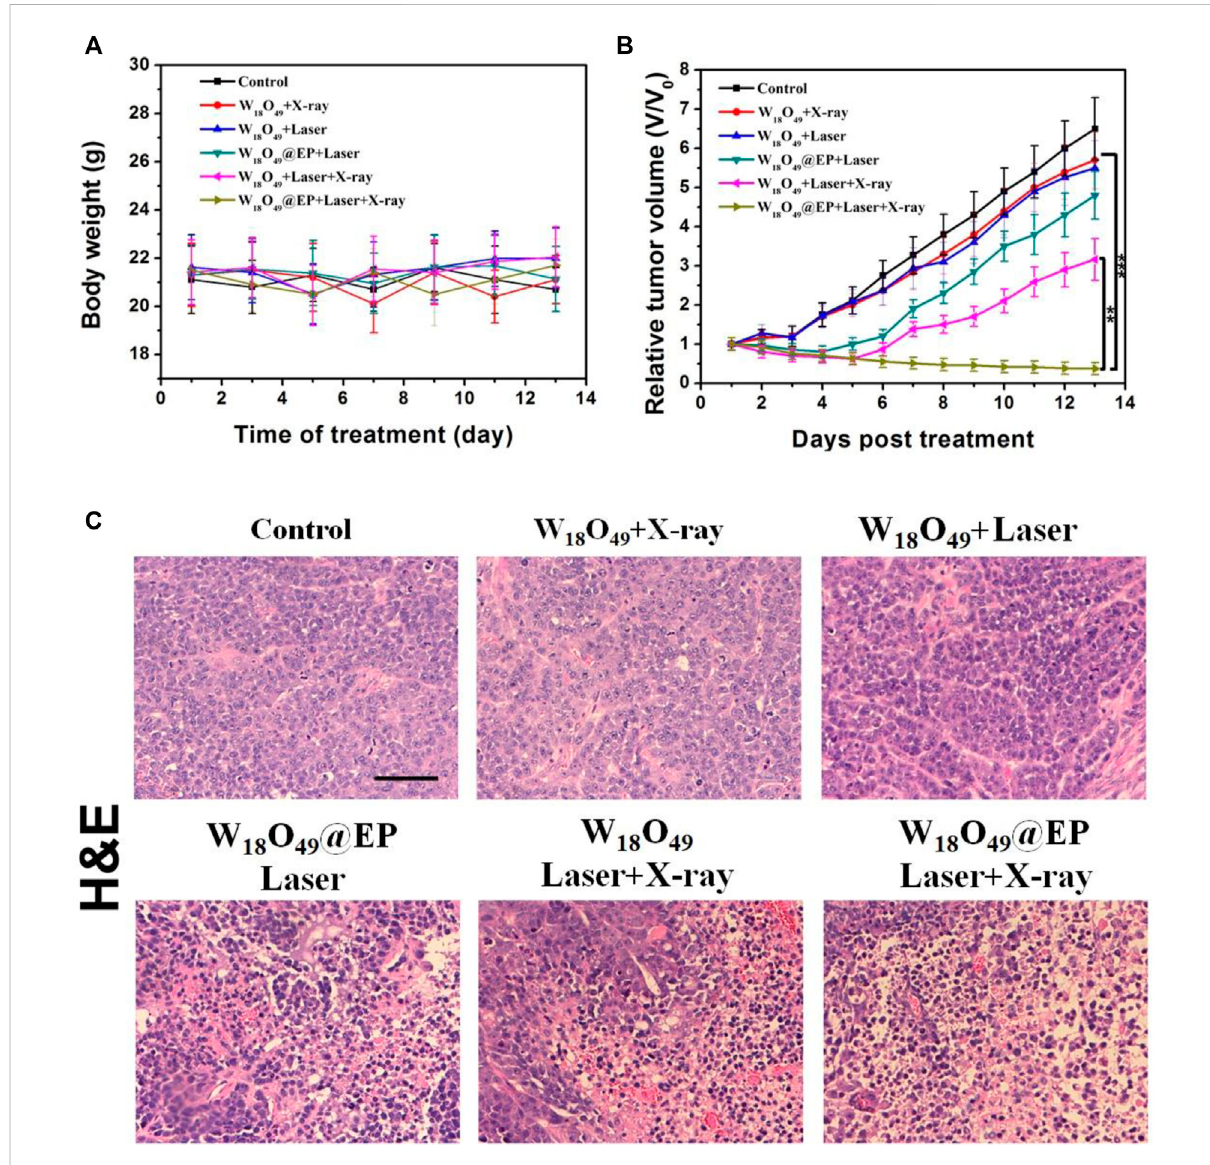
Anti-tumor effect in vivo. (A) Body weight of tumor-bearing mice after different treatments. (B) Tumor volumes of mice receiving different treatments. (C) Sections of tumor tissue after different treatments, stained by